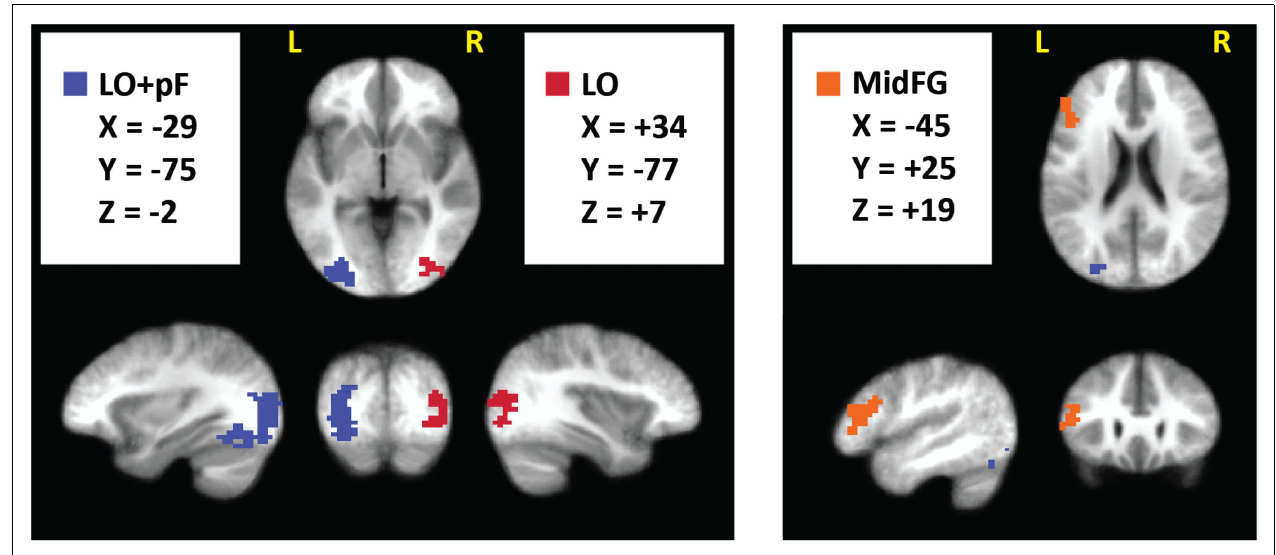
between the perceptual and categorical uncertainty conditions. Surviving clusters are shown here, overlaid on an average of the anatomical images from all